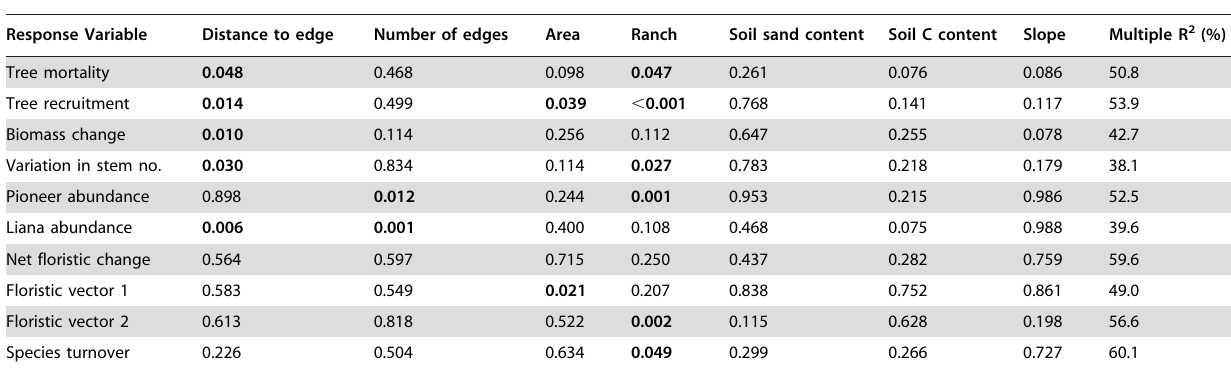
Table 1. Predictors of spatial variability in edge-effect parameters in fragmented and intact Amazonian forests, using general linear